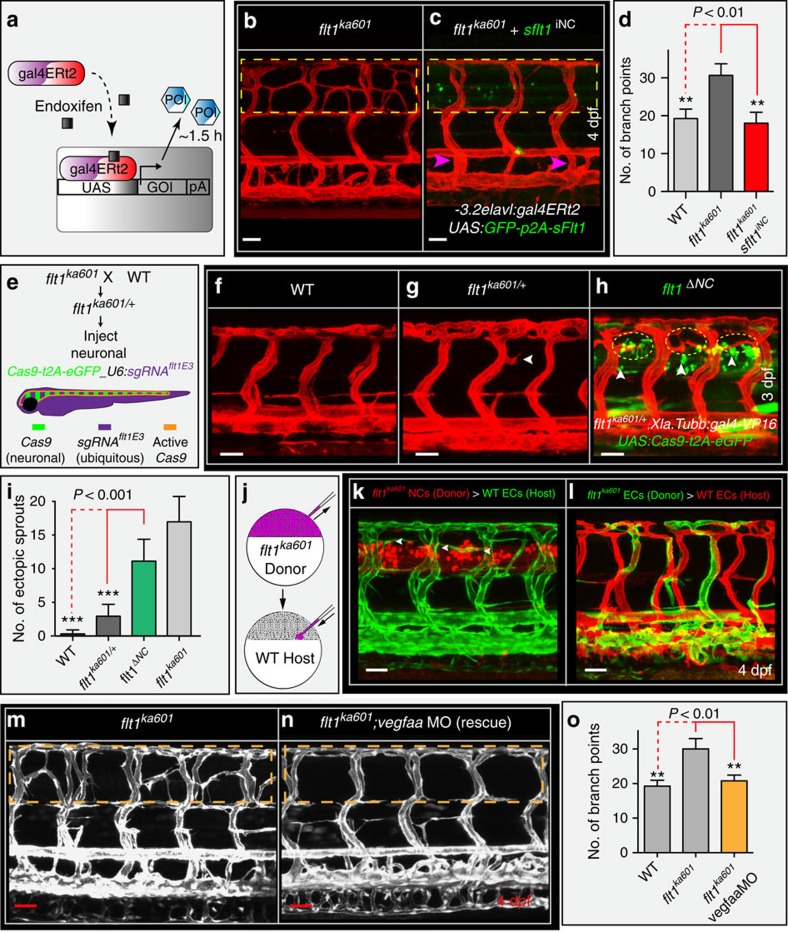
Neuronal Flt1 regulates vascular branching by titrating neuronal Vegfaa.(a) Schematic representation of endoxifen inducible gain-of-function approach in zebrafish. In the present situation Gal4 is under the control of neuron-specific promoters elavl or XIa.Tubb. Expression can be observed within 1.5 h upon endoxifen application. (b) Hyper-branching in flt1ka601 mutants (dotted box). (c) Endoxifen inducible neuron-specific sflt1 gain-of-function rescues hyper-branching in flt1ka601 mutants; compare dotted box in c and b. Purple arrowheads indicate vISVs; endoxifen was applied at 52 hpf. (d) Quantification of rescue in (b,c), mean±s.e.m, n=15-19 embryos per group. (e) Approach for generating a neuron-specific flt1 mutant. Cas9 was expressed under control of neuronal promoter Xla.Tubb; sgRNA was expressed ubiquitously, resulting in Cas9 activity in neuronal cells only (domain marked by orange border). Heterzygous flt1ka601/+ were used to facilitate biallelic knockout. (f–h) Neuron-specific loss of flt1 (flt1ΔNC) induces ectopic sprouting (h), sprouts in yellow dotted ellipse, arrowheads indicate neuronal cells with Cas9 expression. (i) Quantification of ectopic sprouting for indicated genotypes. Note that neuron-specific loss of flt1 significantly augments ectopic sprouting (green bar) mean±s.e.m, n=16 embryos per group, t-test. (j–l) Transplantation of flt1 mutant neuronal cells (k) and endothelial cells (l) into WT. Note: transplantation of flt1 mutant neuronal cells induced sprouting (k, arrowheads); 9 out of 12 neuronal cell transplantations resulted in sprout formation. In all 10 endothelial cell transplantations, sprouts were absent (l). (m,n) Low dose morpholino-mediated reduction of vegfaa expression in flt1ka601 mutants rescues sprouting defects; compare dotted box in (m,n). (o) Quantification of rescue in (m,n), mean±s.e.m., n>5 per group, t-test. DA, dorsal aorta; PCV, posterior cardinal vein; DLAV, dorsal longitudinal anastomotic vessel; NT, neural tube. GOI, gene of interest; POI, protein of interest; iNC, inducible, neuronal cell specific gain-of-function; ΔNC, neuron-specific loss of flt1; MO, morpholino. Scale bar, 50 μm in b–h,m,n; 25 μm in k,l.